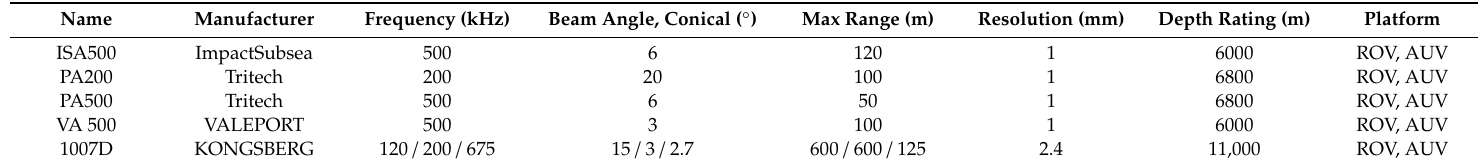
Table 18. Acoustic sensor: altimeter.